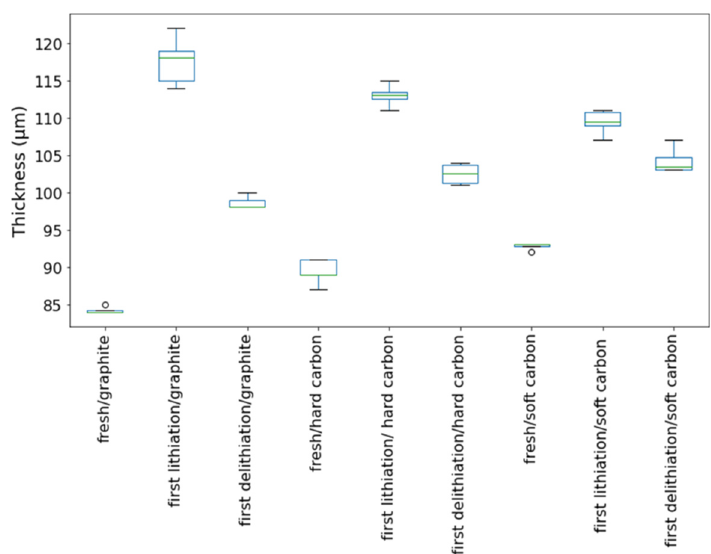
Figure 5. Thickness variation of various SF-anodes at different stages.